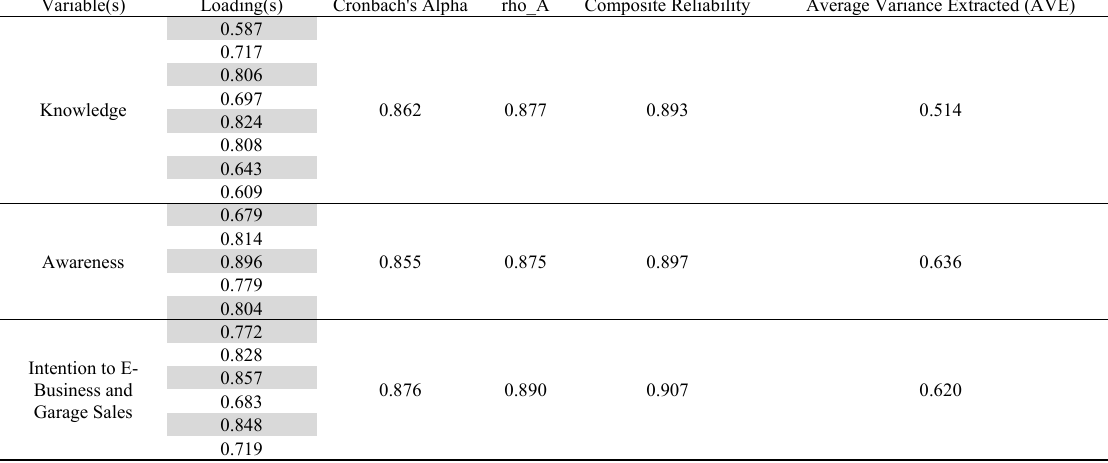
Results of Instruments Validity and Reliability Measurement